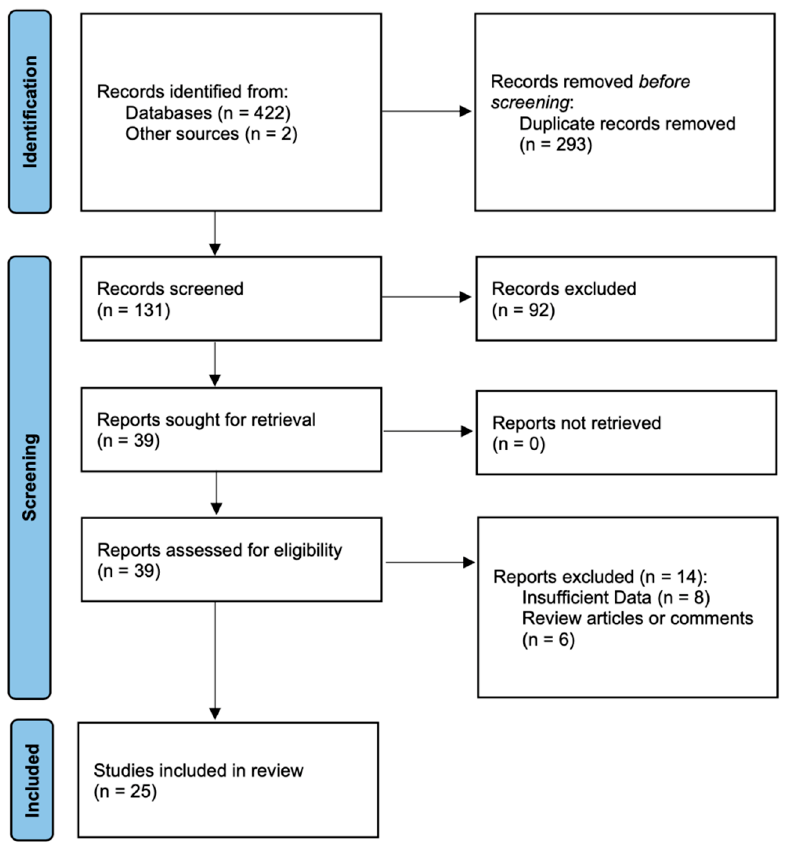
Figure 1. The flow diagram for study search process. Table 1. Baseline characteristics of the included studies.